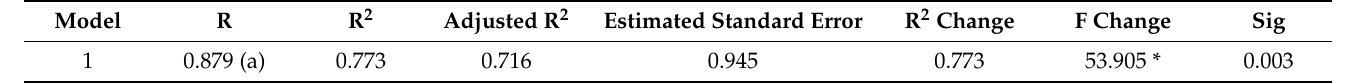
Table 6. Summary of the HS results in multiple regression model 1.